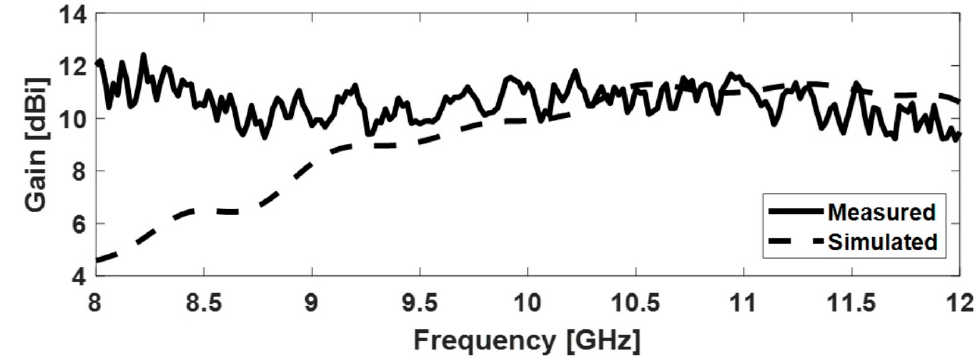
Figure 8. Gain of the pyramidal horn antenna in the main direction of radiation.